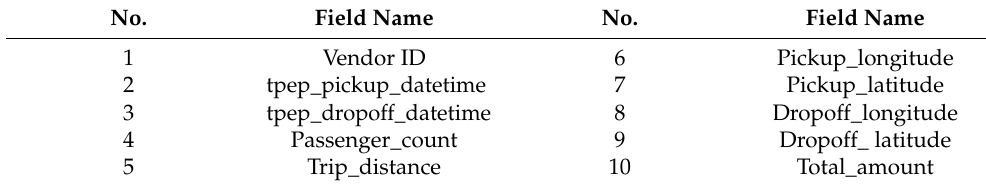
Table 1. New York taxi dataset fields table.